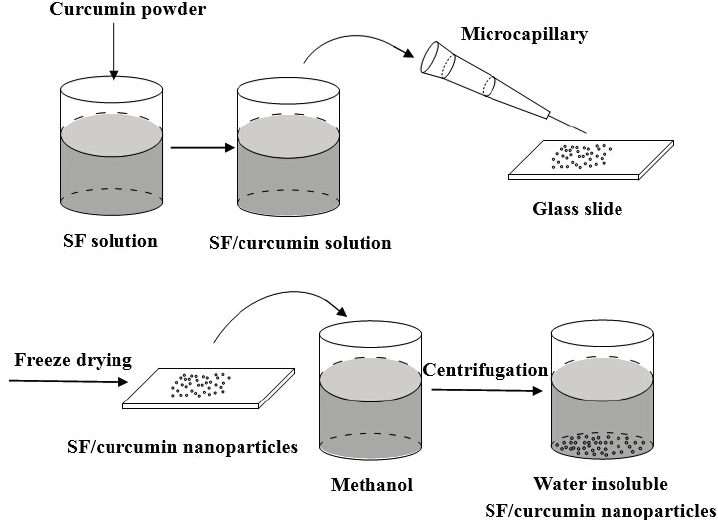
Figure 8. Schematic diagram of the capillary-microdot technique for preparing SF